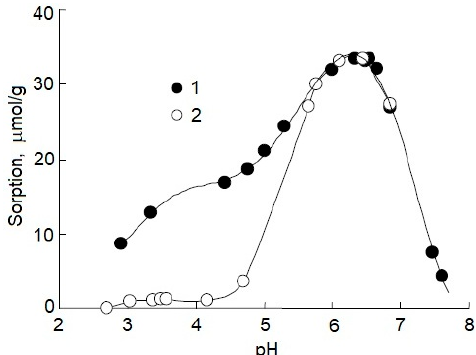
Figure 5. U 6+ sorption on saponite vs the solution pH (ionic force (NaClO 4 ) 0.01(1); 0.1 (2); C(U 6+ ) = 10 − 4 M; m = 0.1 g; V = 50 cm 3 ) Reproduced with permission from G.N. Pshinko et al. [66].